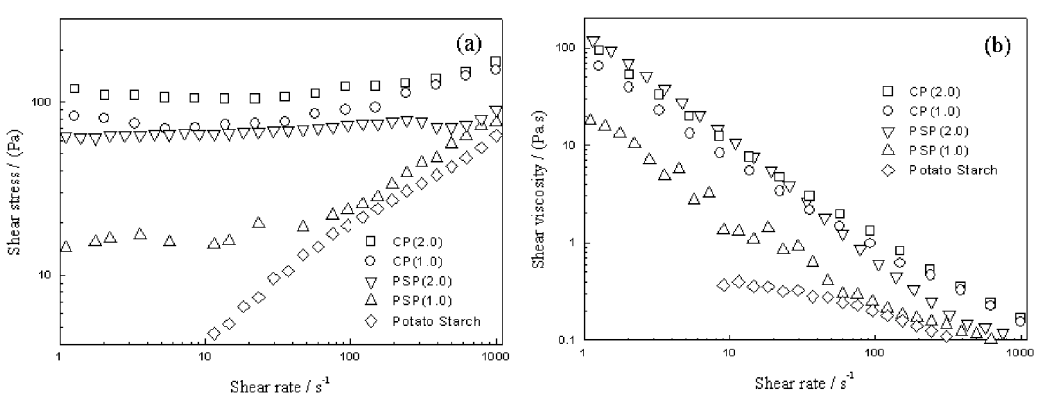
(3) Figure 13. Dielectric properties of an MCC particle based ER fluid: ( a ) dielectric constant and loss factor vs. frequency; and ( b ) dielectric loss vs. dielectric constant (Cole–Cole plot) [93]. Here, ε 0 is the relative permittivity when the frequency is near 0, and ε ∞ is the dielectric value when the frequency is infinite [111]. The difference between these values, ∆ε = ε 0 − ε ∞ , represents the polarizability of the ER fluids, which is related to the electrostatic interactions between the